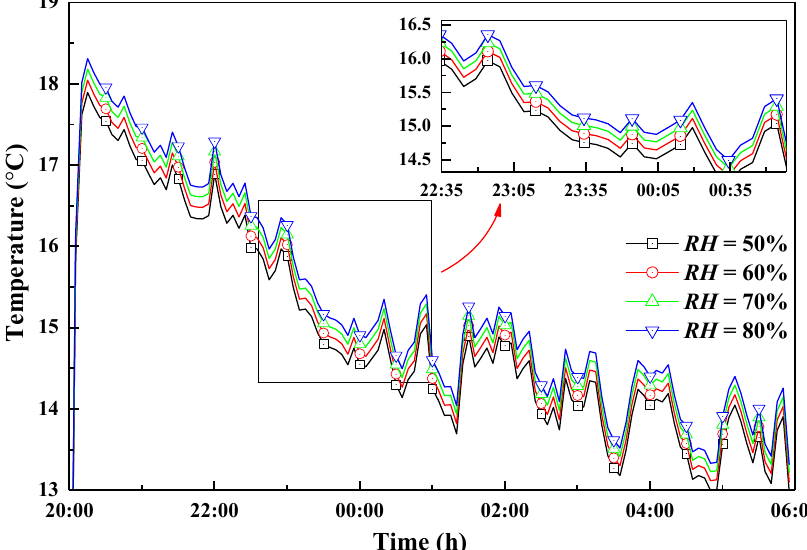
Figure 16. Time-dependent variation of the component surface temperature with the different relative humidities.